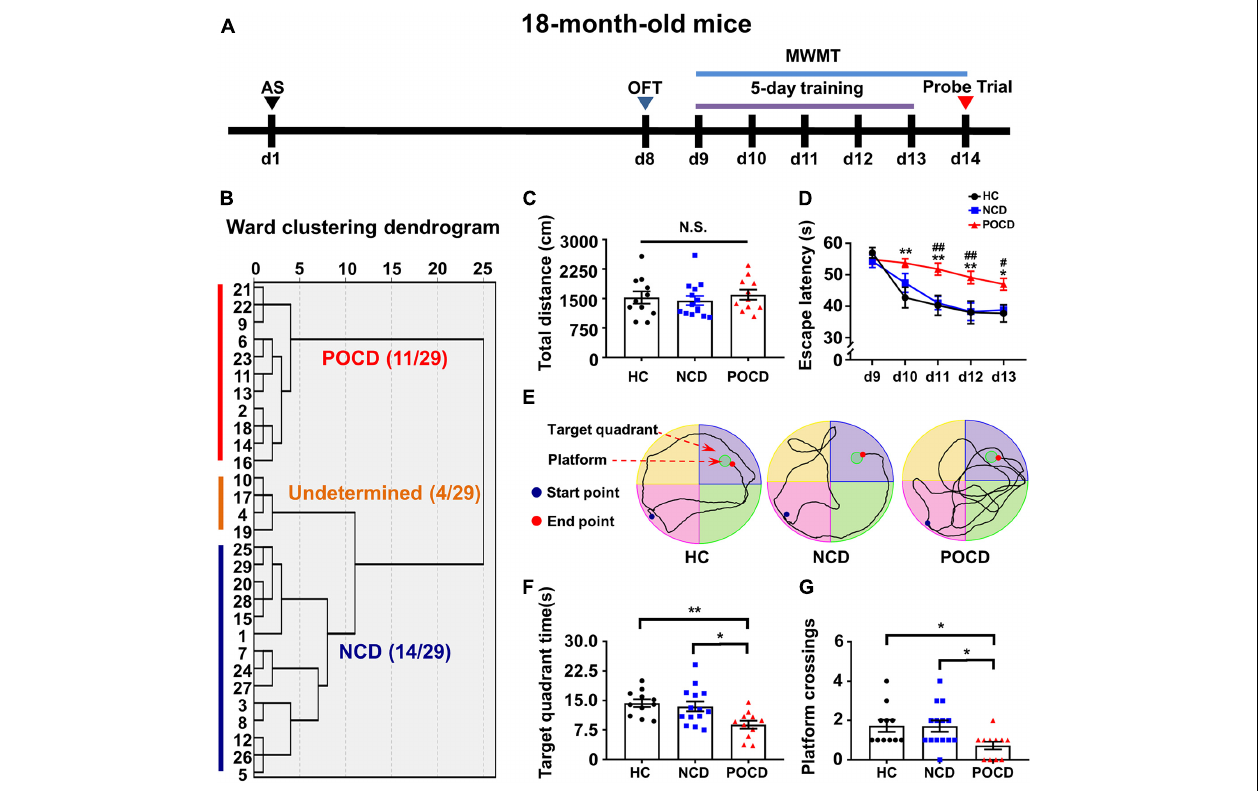
FIGURE 1 | Anesthesia and surgery induced post-operative cognitive impairment in aged mice. (A) The schematic of the Experiment I. Anesthesia and surgery (AS) were performed on day 1 (d1). OFT was performed on day 8 followed by recovery period of 1 week. On day 9–14, mice were trained for MWMT, training test was performed on day 9–13 and spatial probe test was performed on day 14. Then, clustering analysis was performed and tissue samples were collected. (B) Dendrogram of hierarchical clustering analysis. A total of 29 mice after AS were divided into undetermined, NCD and POCD phenotypes by clustering analysis of MWMT results. (C) Total distance in OFT. (D) Escape latency: POCD vs. HC, * P < 0.05 or ** P < 0.01; POCD vs. NCD, # P < 0.05 or ## P < 0.01. (E) Representative trace graphs of HC, NCD, and POCD mice in MWMT on day 13 (the last day of training). (F) Target quadrant time: * P < 0.05 or ** P < 0.01. (G) Platform crossing: POCD vs. HC, U (Mann-Whitney value) = 25.50, * P < 0.05; POCD vs. NCD, U = 35, * P < 0.05. Data are shown as mean ± S.E.M. (HC: n = 11, NCD: n = 14, POCD: n = 11). AS, anesthesia and surgery; d, day; HC, healthy control; MWMT, Morris water maze test; NCD, non-POCD; N.S., not significant; OFT, open